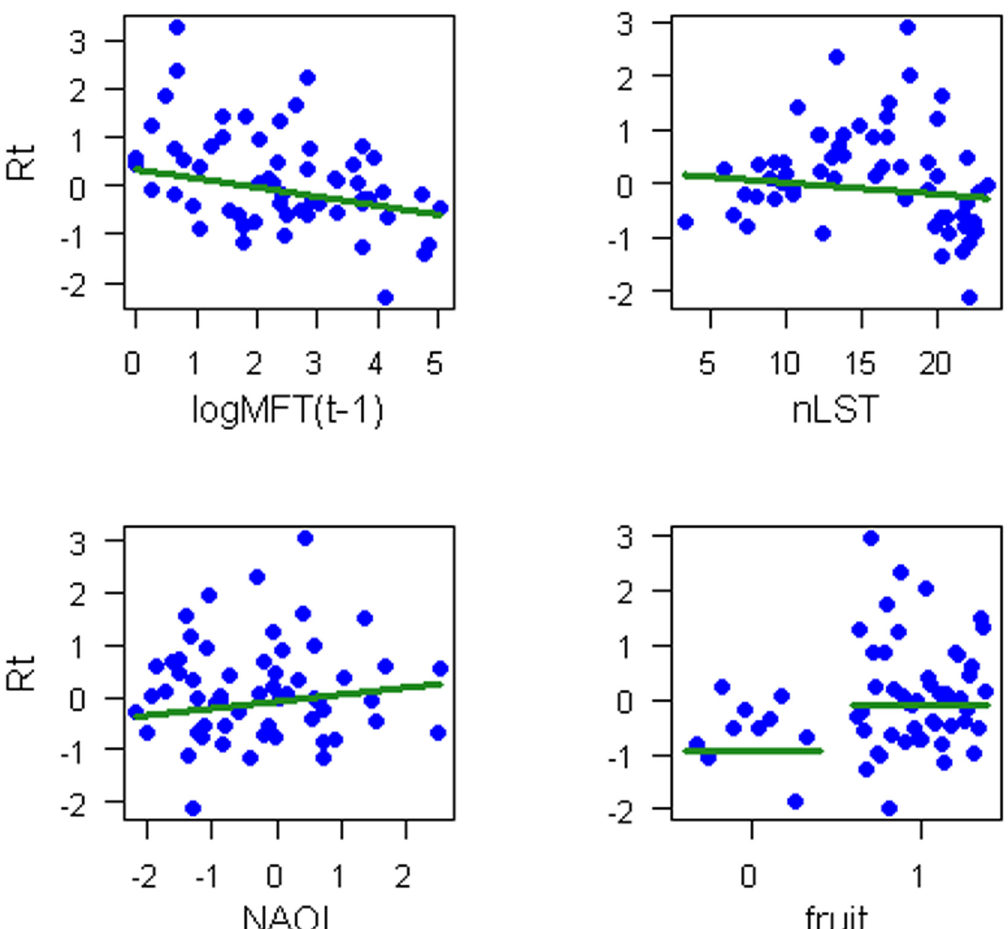
Fig 5. Endogenous and exogenous influences on the rate of population change. Direct endogenous (logMFTt-1) and exogenous (nLST; NAOi; fruit availability, 0: absent, 1: present) influences on the rate of change in the olive fly population ( R t) in Lahav. Observed points are depicted in blue. The fitted line is drawn in green, according to the selected generalized-least-squares model indicating partial regressions (Table 2).